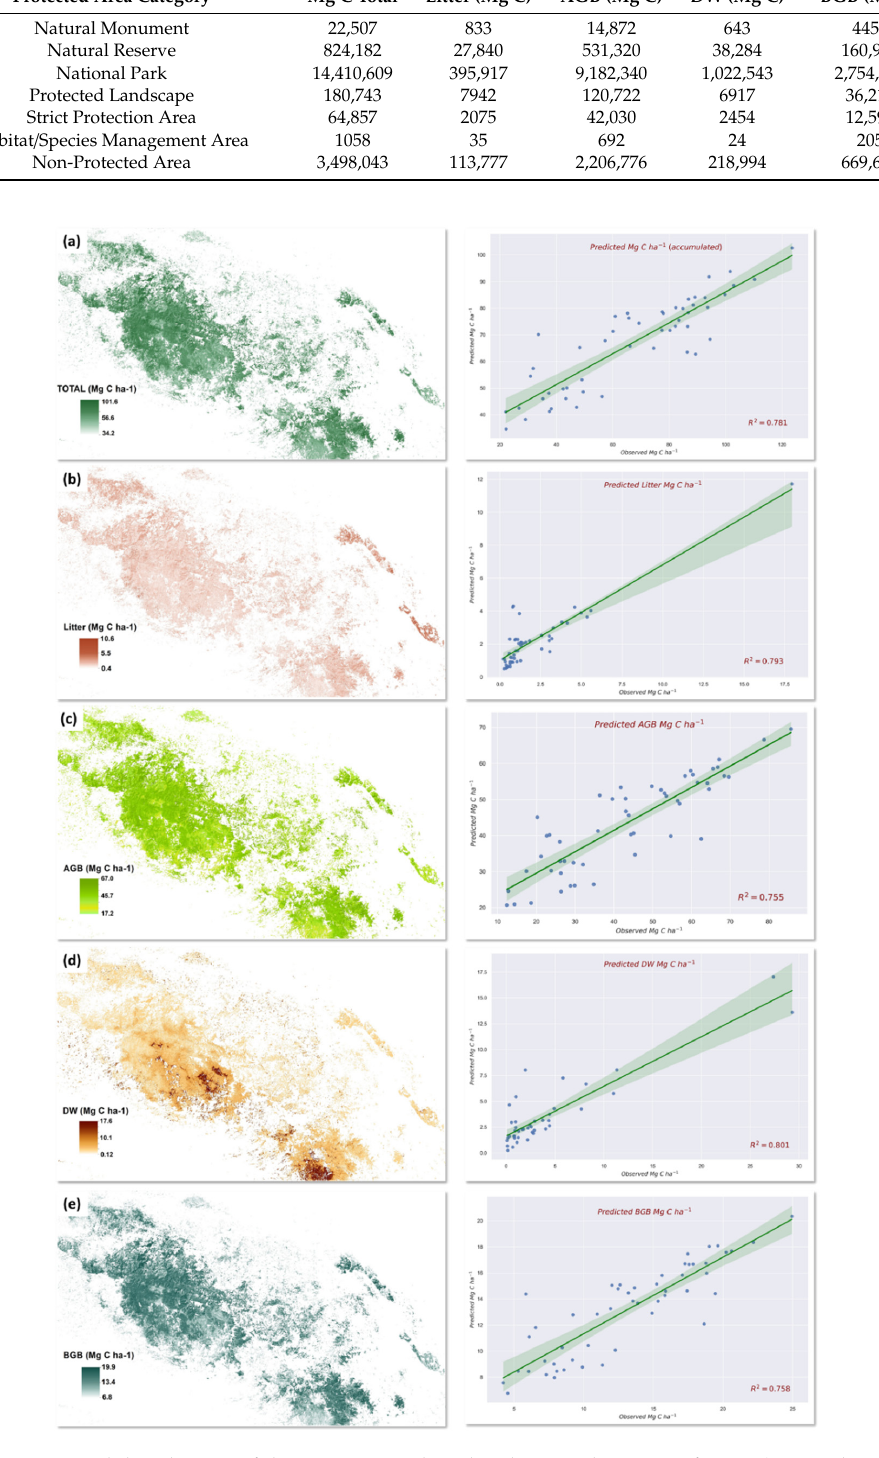
Figure 11. Spatial distribution of the average predicted carbon stocks in pine forests (zoomed in image of the national parks with the highest density of pine forests) and the carbon prediction graph with a 95% confidence interval: ( a ) total carbon; ( b ) litter C; ( c ) AGB C; ( d ) downed dead C; ( e ) BGB C (Note: 1 Mg ha − 1 = 1 ton ha − 1 ). 1 Mg ha − 1 = 1 ton ha − 1